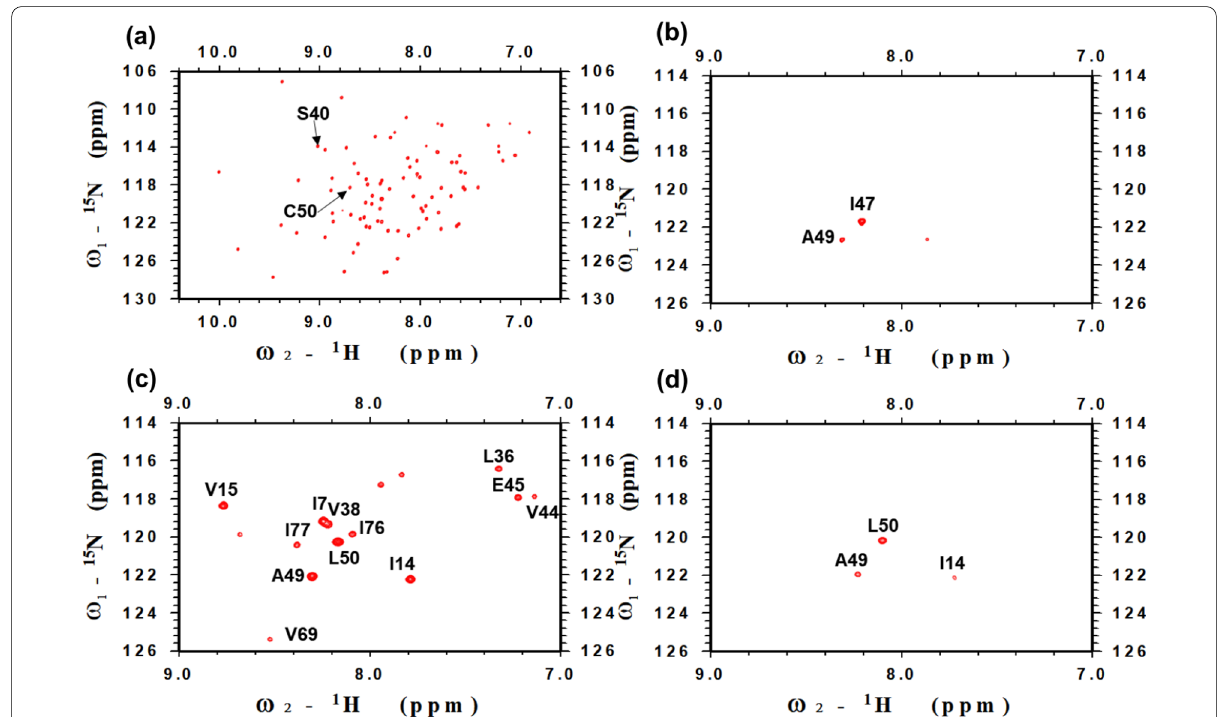
Fig. 4 H/D exchange experiment for CaACP. a The HSQC spectrum of WT CaACP. b The HSQC spectrum of WT CaACP after 30 min. c The HSQC spectrum of CaACP C50L after 30 min. d The HSQC spectrum of CaACP C50L mutant after 120